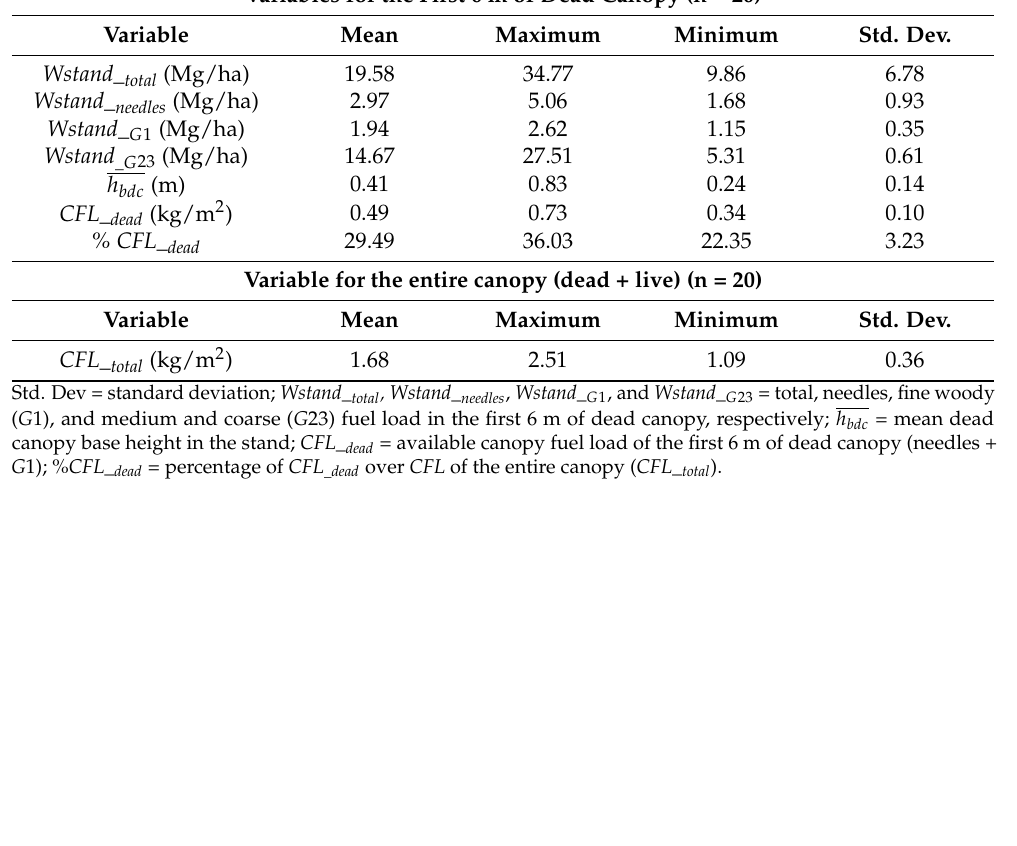
Figure 3. ( Left ) Scatter plots of observed versus predicted values for the vertical distribution of nee- dles ( W acum_needlesj , upper), woody fines ( W acum_G 1 j , middle), and total ( W acum_totalj , lower) individual tree fuel loads. The solid red line denotes the fitted linear model and the dashed line denotes perfect agreement. ( Right ) Box plots of the vertical distribution of residuals of needles ( W acum_needlesj , upper), woody fine ( W acum_G 1j , middle), and total ( W acum_totalj , lower) individual tree fuel loads according to heights from ground level. Blue dots denote the mean values. Table 3. Statistics for the main variables in the first 6 m of dead canopy and the entire canopy. Variables for the First 6 m of Dead Canopy (n =